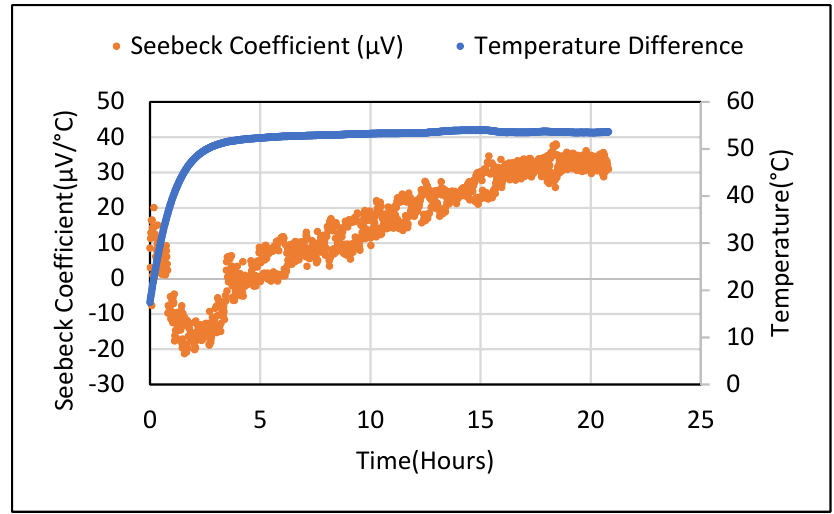
Figure 14. Seebeck coefficient values after drying the 5 wt.% Fe 2 O 3 sample in oven for 24 h.